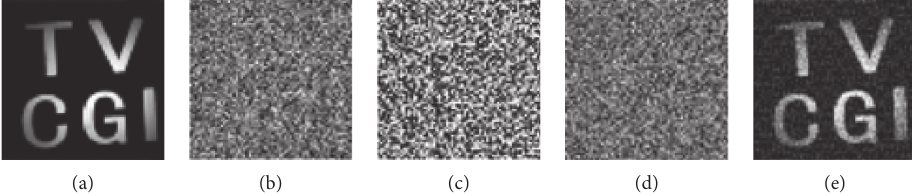
Figure 7: Experimental results of optical encryption. (a) Original image obtained by CGI using the Hadamard matrix. (b) Imaging result after encryption. (c) Random cipher pattern. (d) Imaging result after decryption using the incorrect cipher pattern. (e) Imaging result after decryption using the correct cipher